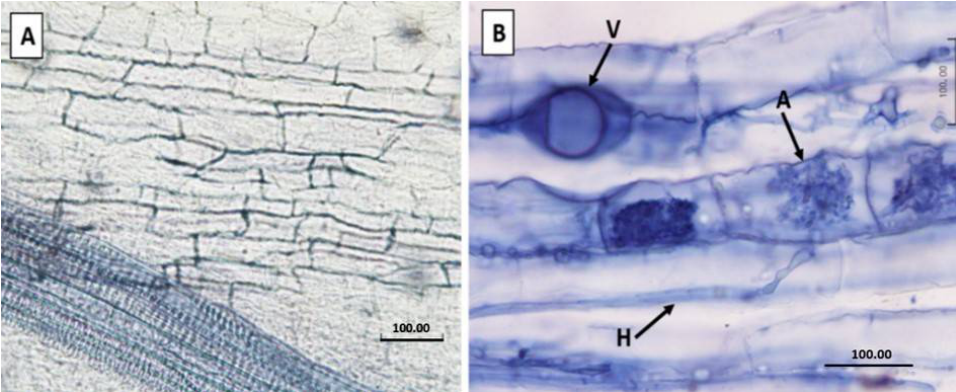
Figure 1. AMF colonization confirmation using Trypan blue stain. ( A ): Grapevine roots of 101-14 rootstock from the uninoculated AMF control. ( B ): Grapevine roots of 101-14 rootstock pre-colonized with 101-14 AMF community. V: vesicle, A: arbuscules, H: hypha. Scale bar represents 100 µm.